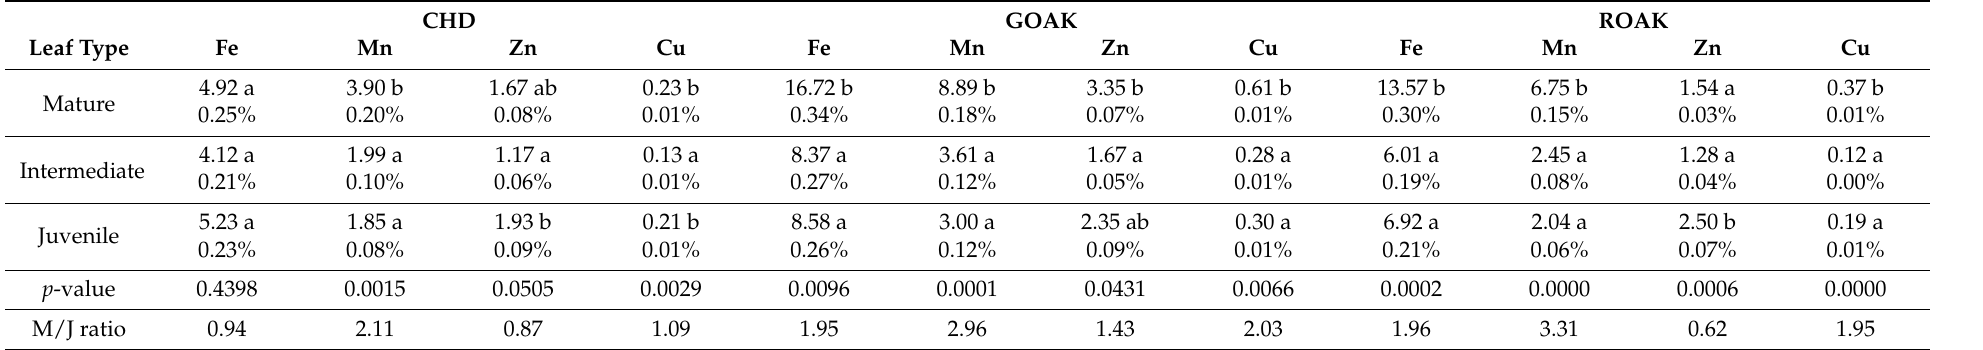
Table 3. Analysis at the cultivar level (CHD, GOAK, and ROAK) and by leaf type of the micronutrients studied in this trial (ppm). Percentages to the proportion of each nutrient in each type of leaf. Data are means of 12 replicates with different letters for each column indicating significant differences ( p -value < 0.01) as determined by LSD multiple comparisons test in different types of leaves